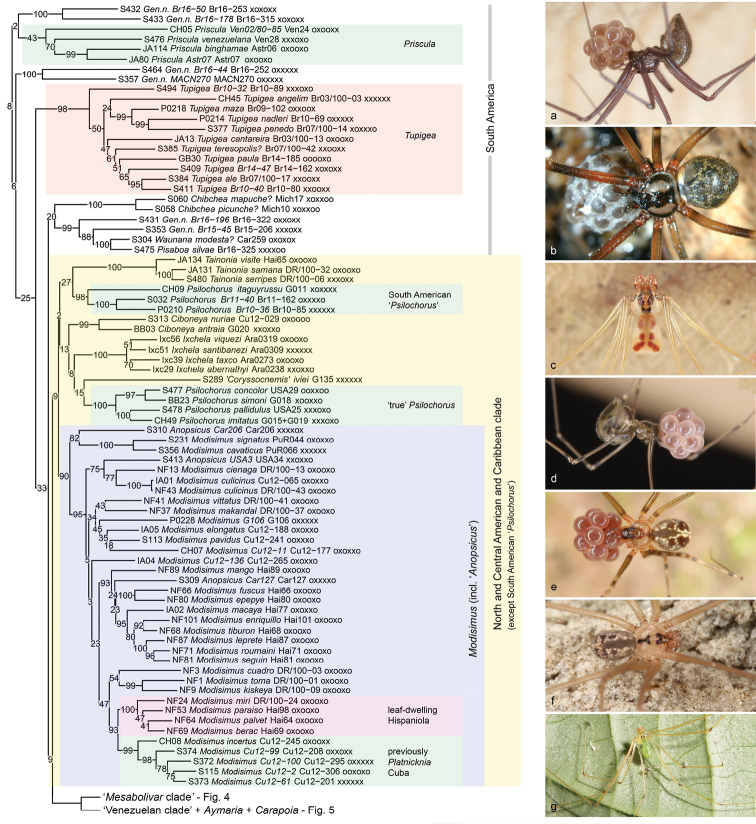
‘Basal’ Modisiminae a Gen. n., sp. n. “Br16-50” (Brazil) bPrisculaandinensis? (Venezuela) c Gen. n., sp. n. “Br16-196” (Brazil) dTupigea sp. n. “Br14-47” (Brazil) ePisaboasilvae (Brazil) fPsilochorusimitatus (USA) gModisimusincertus (Cuba).